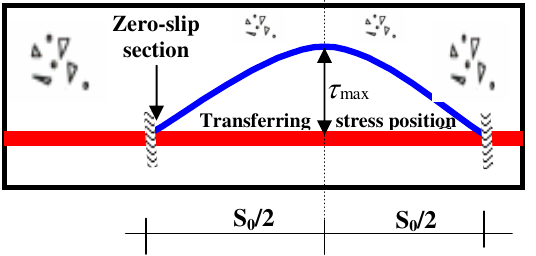
Fig. 1. Bond distribution used in bending member, where τ is the maximum bond value at x = s0/2 measured max from the uncracked